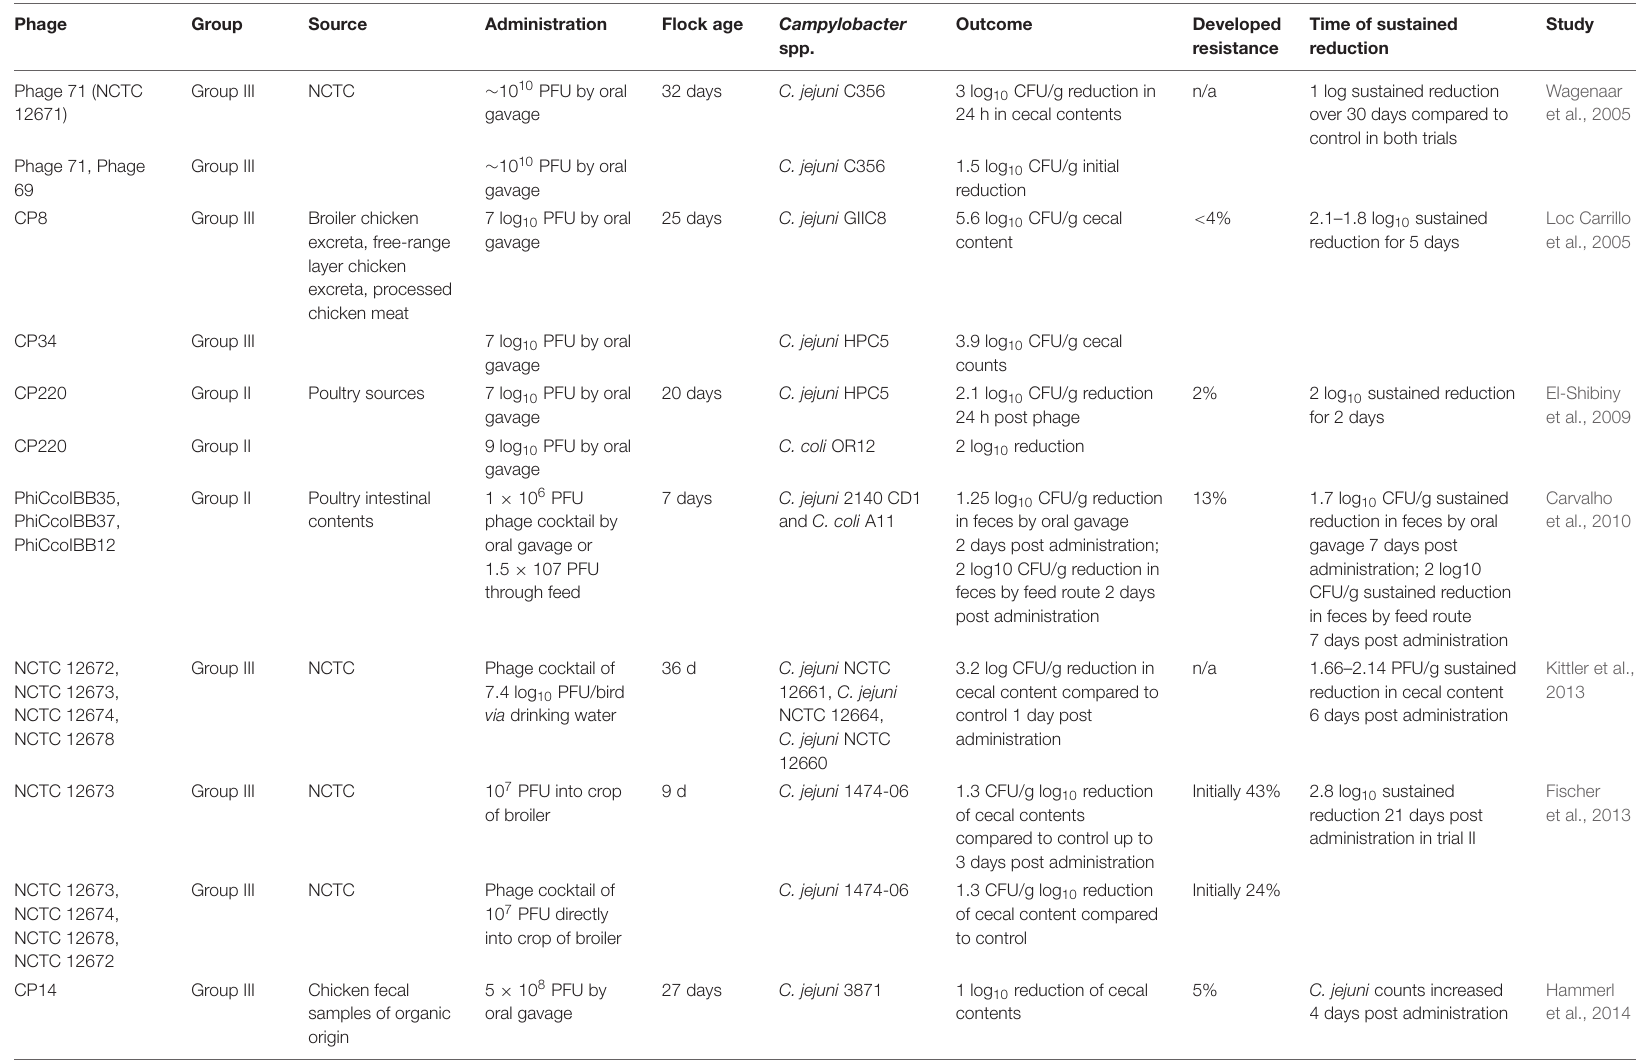
TABLE 2 | Campylobacter phage treatments during in vivo preharvest studies. Phage Group